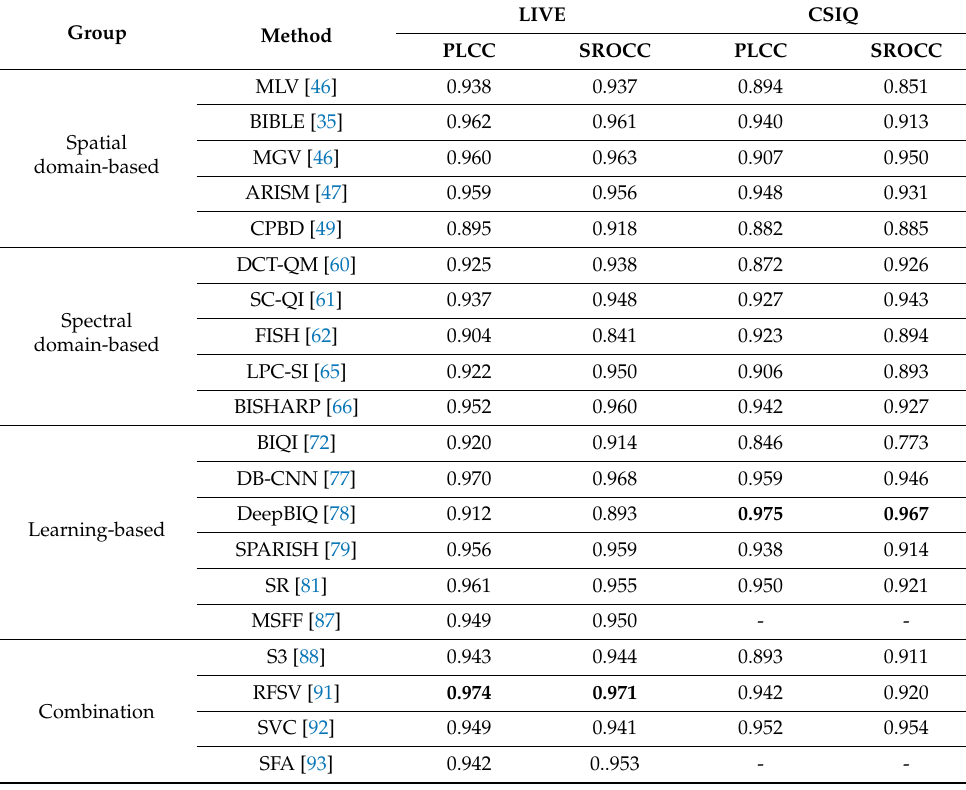
Table 5. Comparison of different evaluation methods on LIVE dataset and CSIQ dataset.